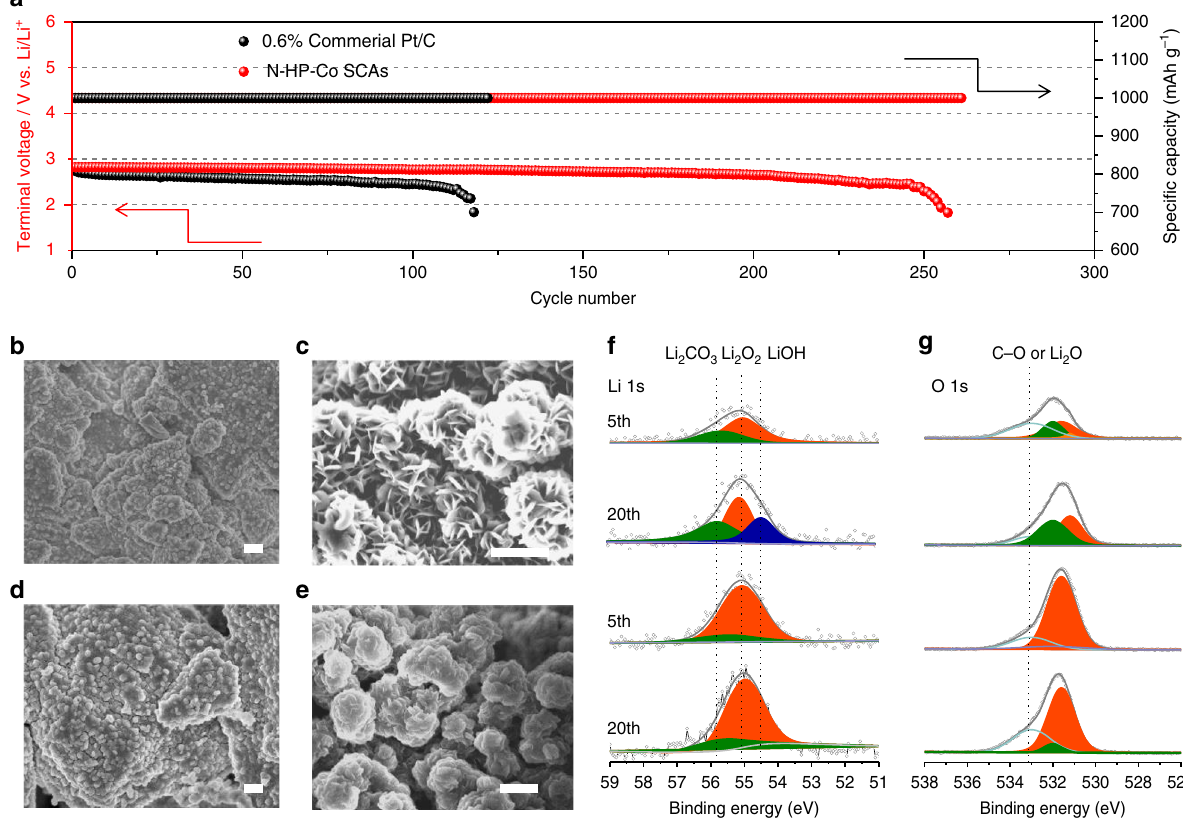
Fig. 6 Cycling stability of Li – O 2 batteries with N-HP-Co SACs. a Voltage versus cycle number on the discharge terminal of the Li – O 2 cells with commercial Pt/C and N-HP-Co SACs. FESEM images of the discharged cathode with the 0.6% commercial Pt/C catalyst ( b ) and the N-HP-Co SAC catalyst ( c ) at a current density of 200 mA g − 1 after the 5th cycle and the cathode with the 0.6% commercial Pt/C catalyst ( d ) and the N-HP-Co SAC catalyst ( e ) after the 20th cycle. One micrometer in b , d ; 500 nm in c , e ; f , g XPS spectra of the discharged cathodes with 0.6% commercial Pt/C and N-HP-Co SACs: Li 1 s ( f ) and O 1 s ( g ) after the 5th and 20th